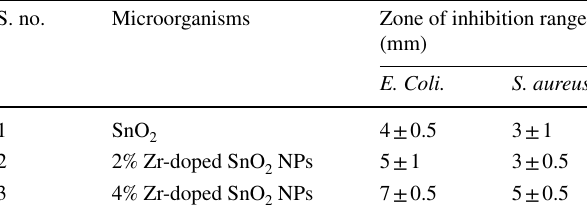
Table 2 Assessment on zone of inhibition of antibacterial activity for as-prepared